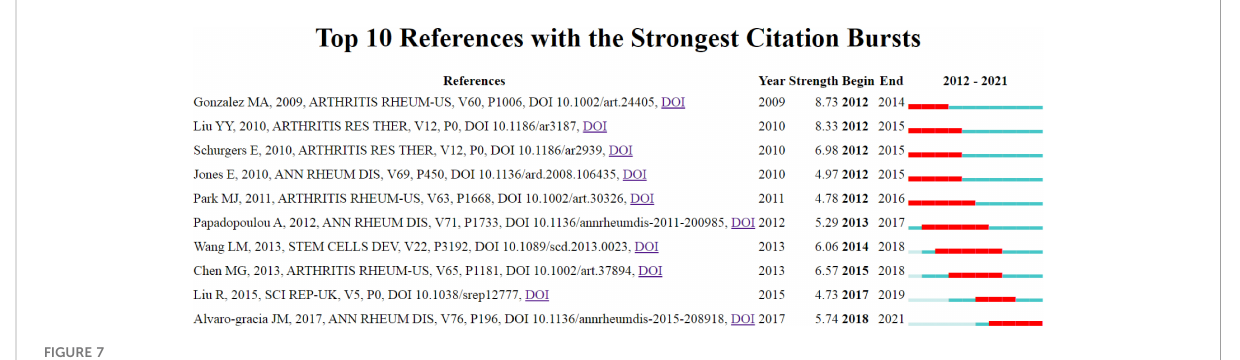
TABLE 4 The main content of the 10 references with strong citations bursts. The references are ranked by beginning year of burst. Rank Main Content Strength 1 Treatment of experimental arthritis by inducing immune tolerance with human adipose-derived mesenchymal stem cells